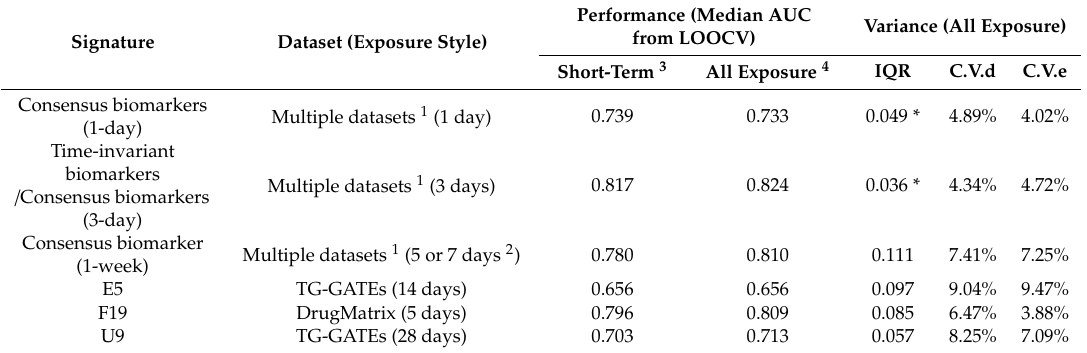
Table 3. Performance of the time-invariant, consensus, and published biomarkers using Random